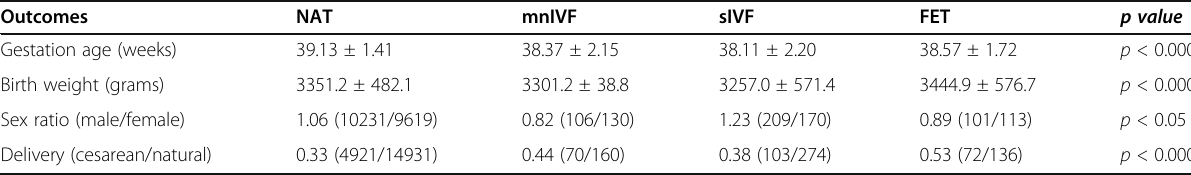
Table 2 Perinatal outcomes of included patients